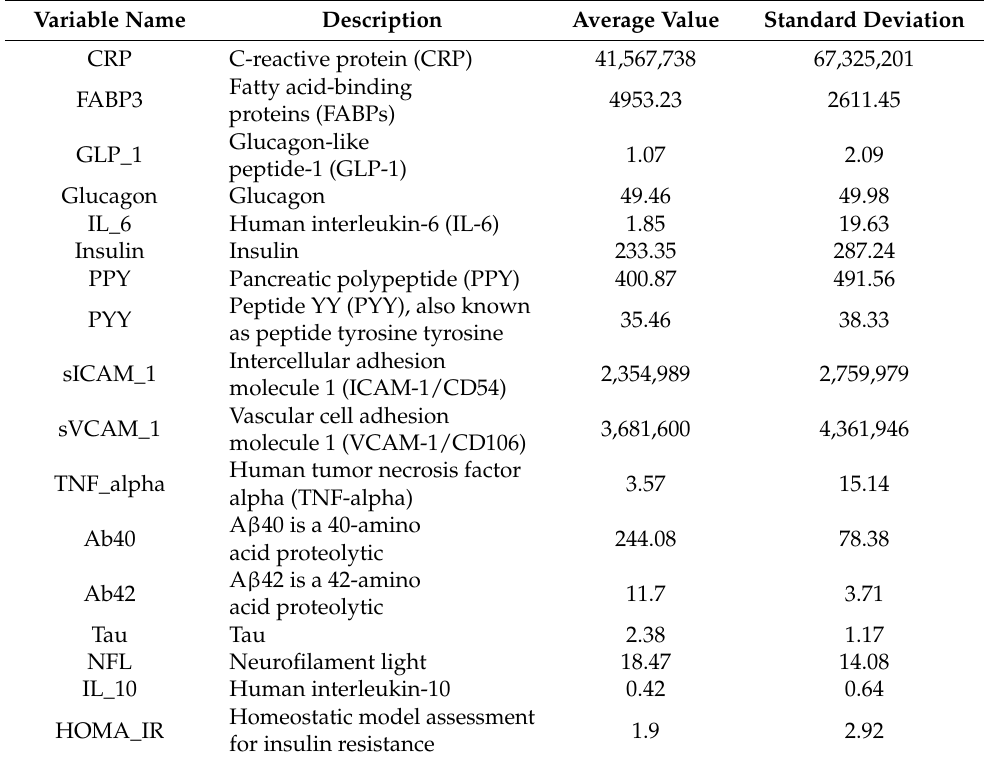
Table 2. Description for the 17